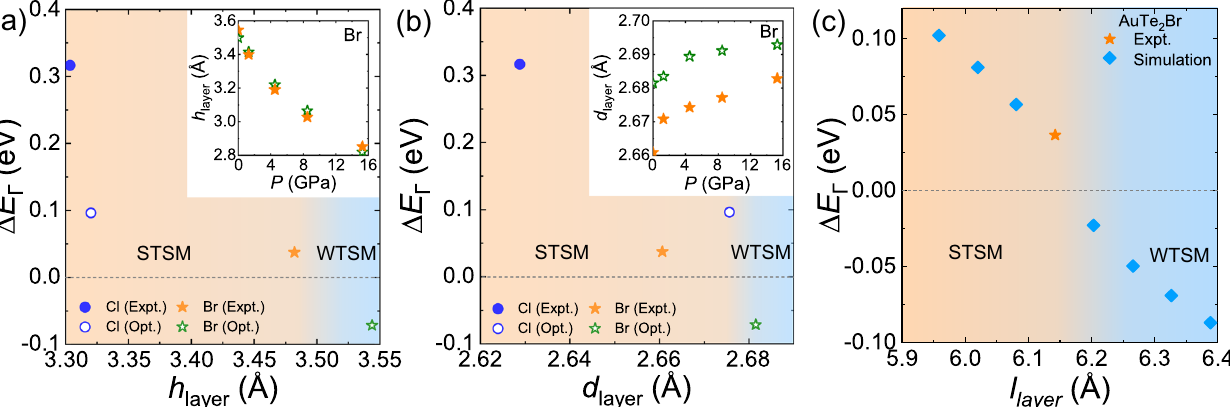
Fig. 4 The topology of AuTe 2 Cl and AuTe 2 Br as a function of representative structural parameters and pressure. a , b The topology — being a strong topological semimetal (STSM) or weak topological semimetal (WTSM) — of AuTe 2 Cl (labeled as Cl) and AuTe 2 Br (labeled as Br), as represented by the energy difference between Au- d xz/yz and Te- p z bands at the Γ point, as a function of h layer and d layer , respectively. Insets in ( a ) and ( b ) are pressure dependence of h layer and d layer , respectively. c l layer dependence of Δ E Γ . The orange star represents the experimental data, while the cyan squares stand for the simulation data obtained from allowing l layer to vary with the orange star as the starting point, while keeping other structural parameters unchanged. Through l layer tuning, the topological transition from STSM to WTSM may be realized.